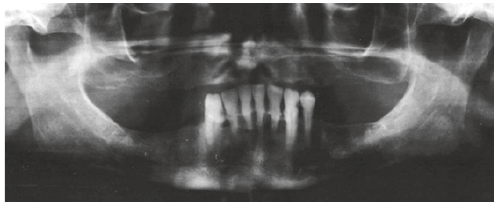
Figure 2: Panoramic radiograph showing horizontal bone loss in the region of mandibular anterior teeth, consistent with chronic periodontitis.